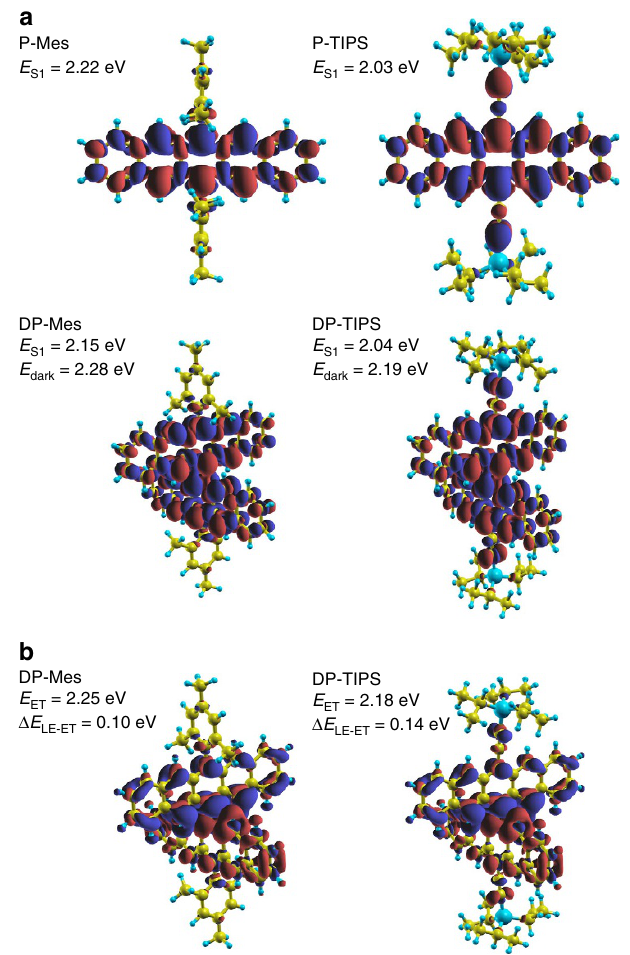
Figure 3 | Excited-state wavefunctions. ( a ) S 1 excitation energies and transition densities for P-Mes, DP-Mes, P-TIPS and DP-TIPS, as determined from TDDFT 51 . The lower energy in -TIPS molecules can be largely attributed to delocalisation on the C-C triple bonds. The dimer S 1 state shown is the bright combination of monomer transitions. The energy of the dark combination with anti-parallel monomer transition dipoles is also indicated. ( b ) ET excitation energies and electron–hole densities for DP-Mes and DP-TIPS in vacuum, as determined from constrained DFT 51 . The effect of solvent is considered in Supplementary Fig.